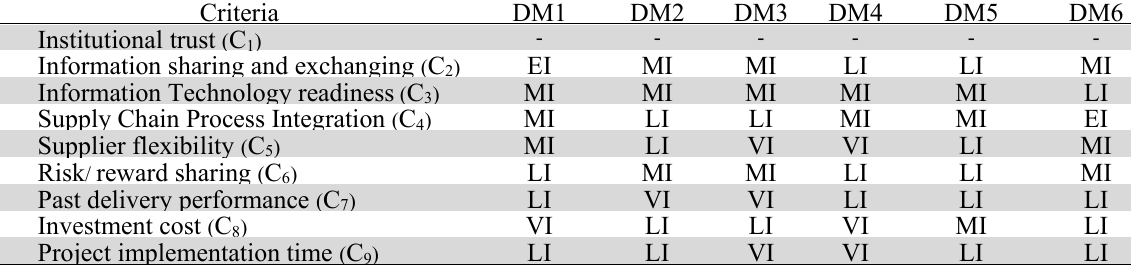
The relative importance weight of each criteria in linguistic term